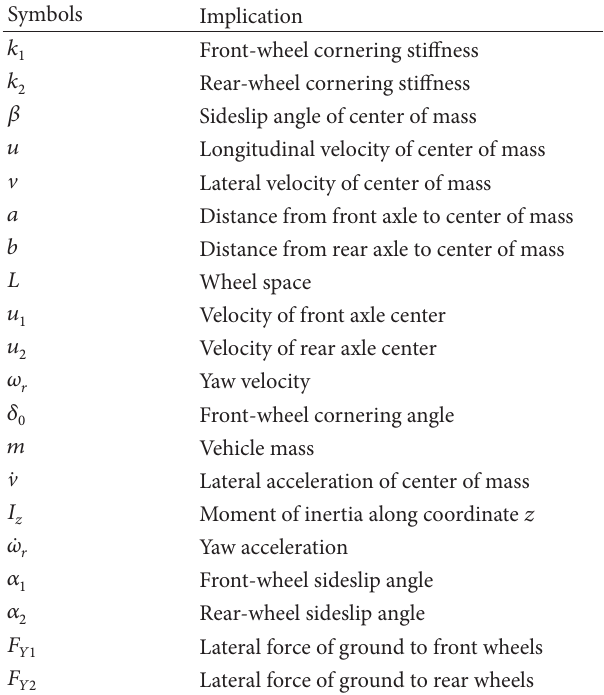
Table 1: Implication of all